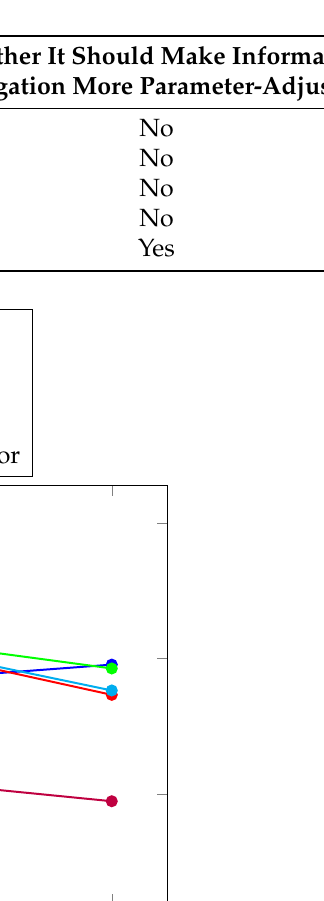
Table 7. Qualitative evaluations of the current methods.